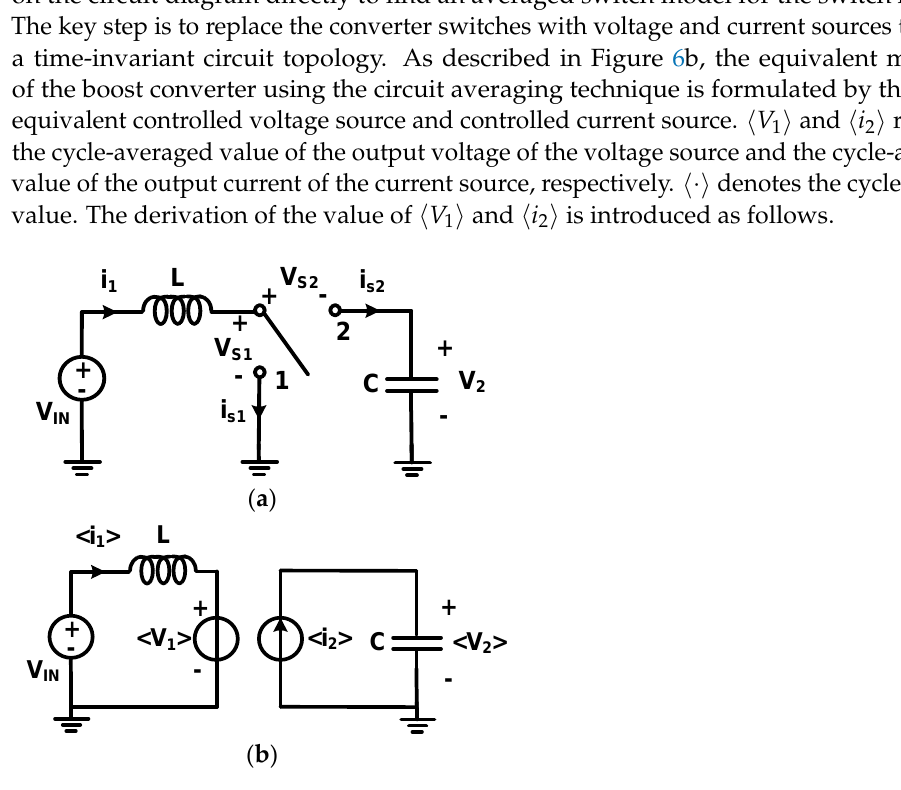
Figure 6. The equivalent modeling of a boost converter. ( a ) Switch model of a boost converter; ( b ) Averaged circuit model of a boost converter.